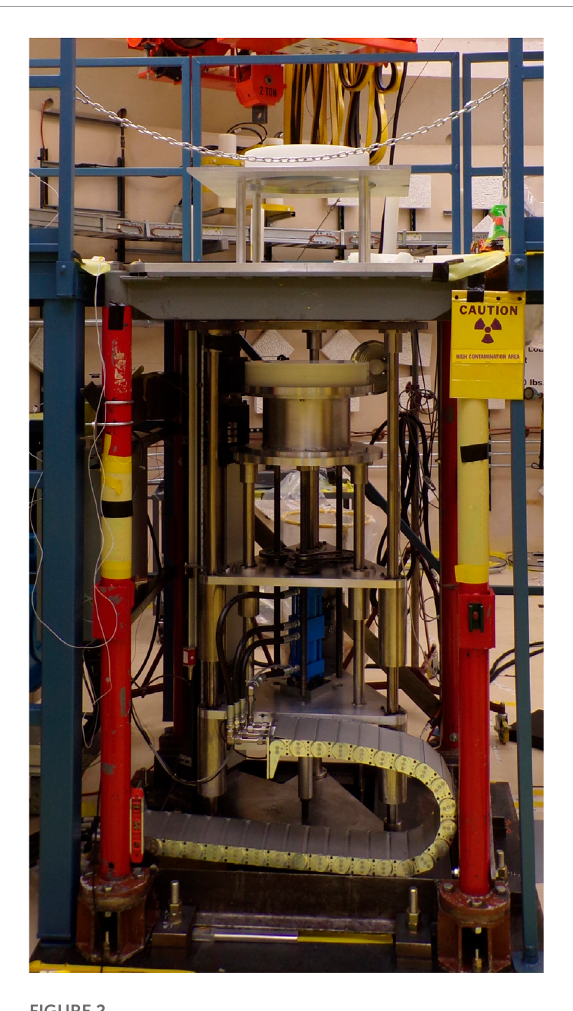
FIGURE 2 Photo of the Comet assembly.